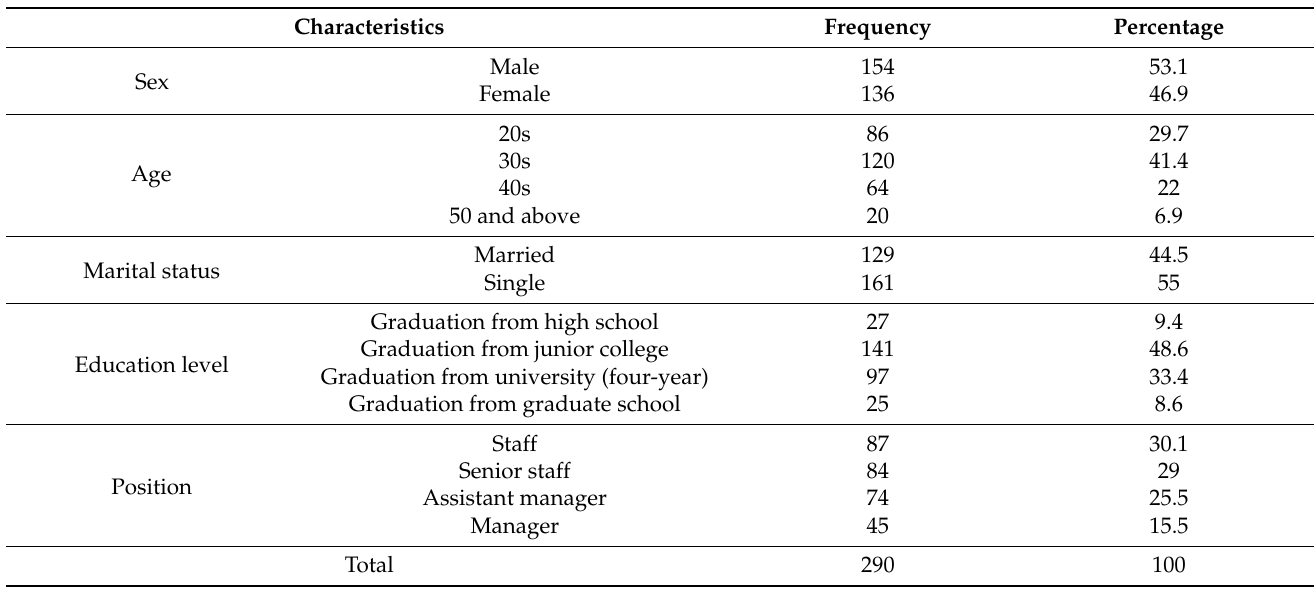
Table 1. Participant